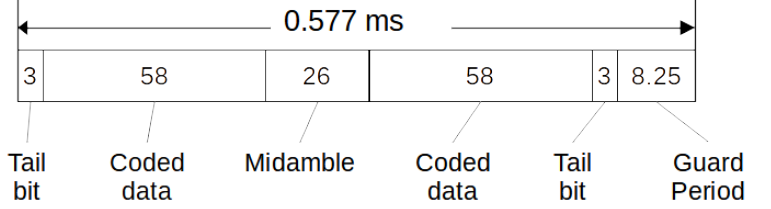
Figure 2. Time slot format for